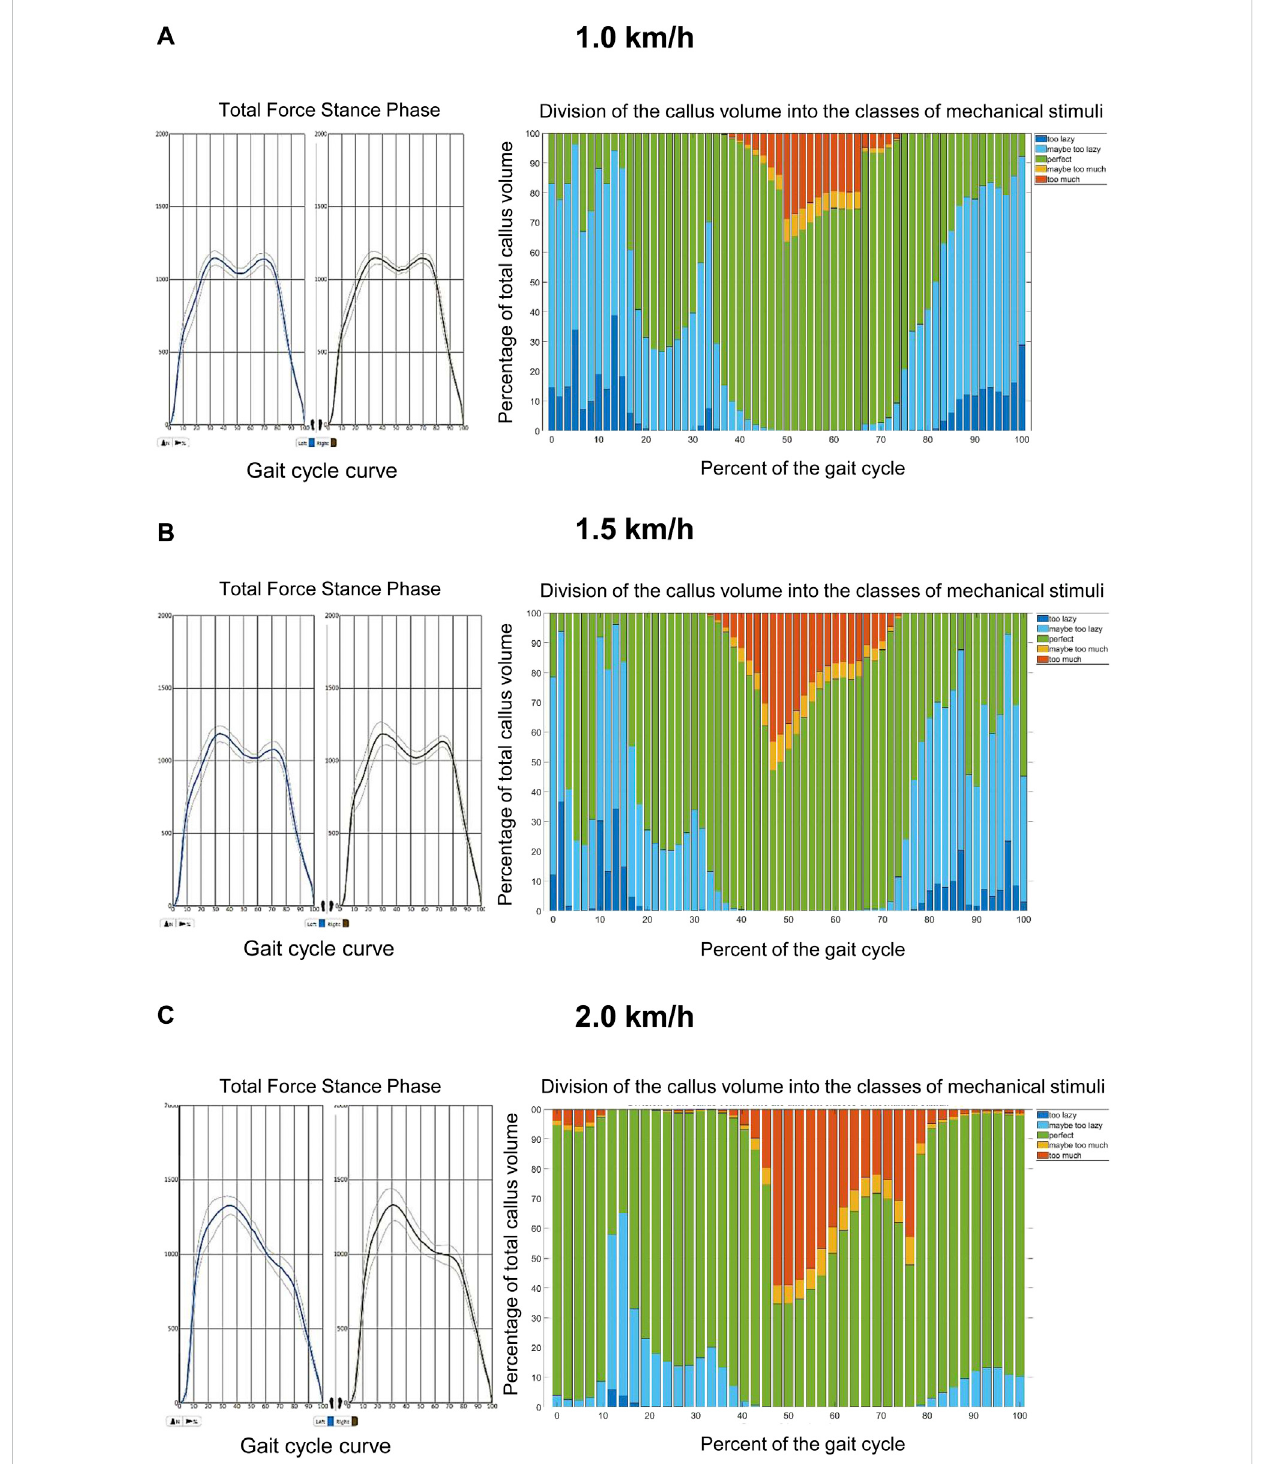
FIGURE 4 Results of motion data at different walking speeds on the treadmill. (A) : At 1.0 km/h the tetrahedral elements located within the fracture gap of the tibia are predominantly within the range of good mechanical properties for healing and bone formation (bars in blue, green and yellow). Only during the middle and end of the stance phase, a short maximum of 38.4% of the elements drop out of this healing range (bars in red). The shape of the gait cycle curve at this velocity has a typical biscuspid form. (B) : At 1.5 km/h tetrahedral elements located within the fracture gap of the tibia are also mostly within the range of good mechanical properties for healing and bone formation during the gait cycle (bars in blue, green and yellow). During the middle and end of the stance phase, a maximum of 52.8% of the elements drop out of this healing range (bars in red). The shape of the gait cycle curve at this velocity has a typical biscuspid form. (C) : At 2.0 km/h tetrahedral elements out of the range of good mechanical properties for healing and bone formation (bars in red) located within the fracture gap of the tibia can be found throughout the whole gait cycle and show a maximum of 65.3% of